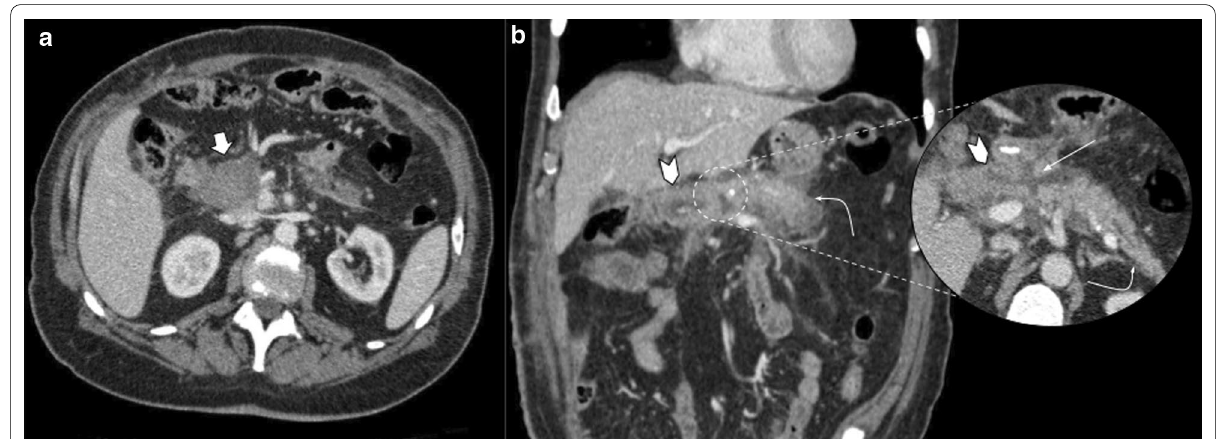
Fig. 15 Pancreatic fistula, ( a , b ) Axial and coronal portal venous phase CT scan, respectively. 72-year-old male patient with pancreaticoduodenectomy due to neuroendocrine tumor, during second-month control CT scan. Homogeneous collection (big arrow) in surgical bed. That collection impresses to be in contiguity with the PJ (straight arrow). Normal pancreatic stump (curved arrow) and afferent loop (arrowhead) are also noted